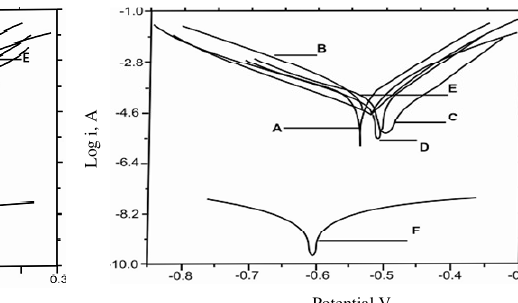
Figure 2. Polarization curves for mild steel corrosion in hydrochloric acid with AV (A-blank, B-0.02%AV, C-0.04%AV, D-0.06%AV, E-0.08%AV, F-0.10%AV)